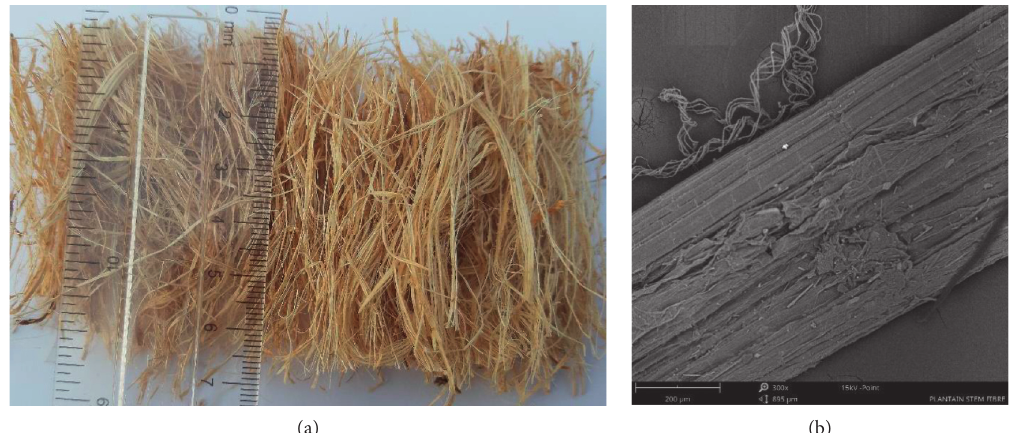
Figure 1: Photograph of plantain pseudostem fibres and SEM image (300 x ) of a single fibre. (a) Cut fibre photograph. (b) Single fibre SEM image.